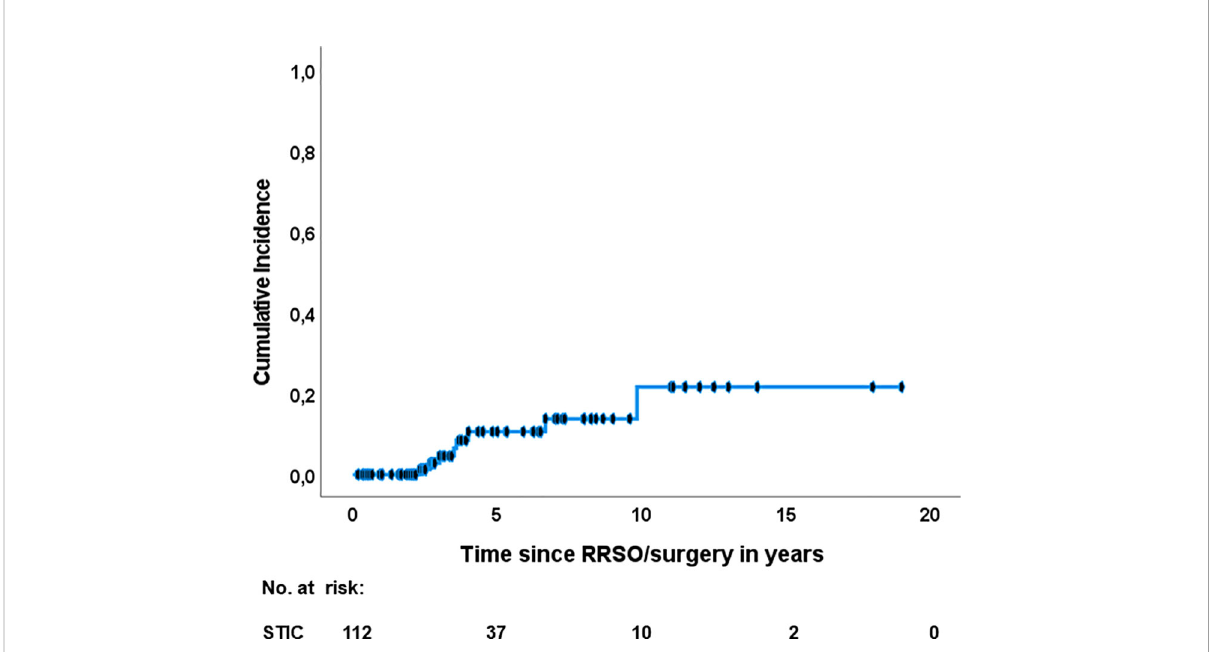
FIGURE 2 Recurrence of HGSC after isolated STIC diagnosis. RRSO risk reducing salpingo-oophorectomy; STIC, serous tubal intraepithelial